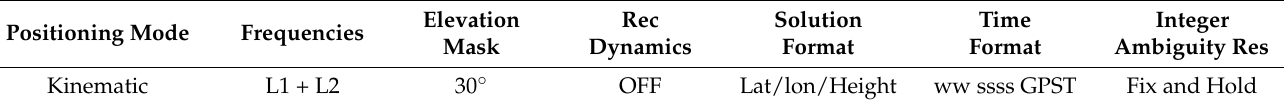
Table 1. The main options used for the rtkpost